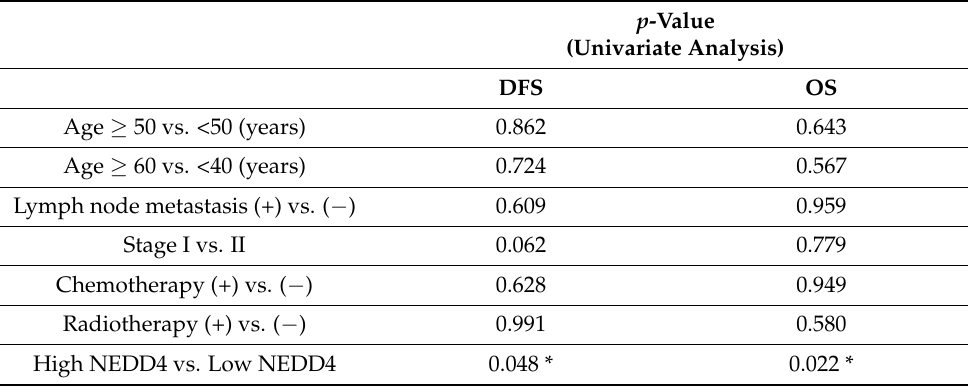
Table 2. Univariate log-rank analyses for prognostic factors and the NEDD4 mRNA level of HR- positive HER2-negative breast cancer; p -values that are statistically significant ( p < 0.05) are marked with an asterisk